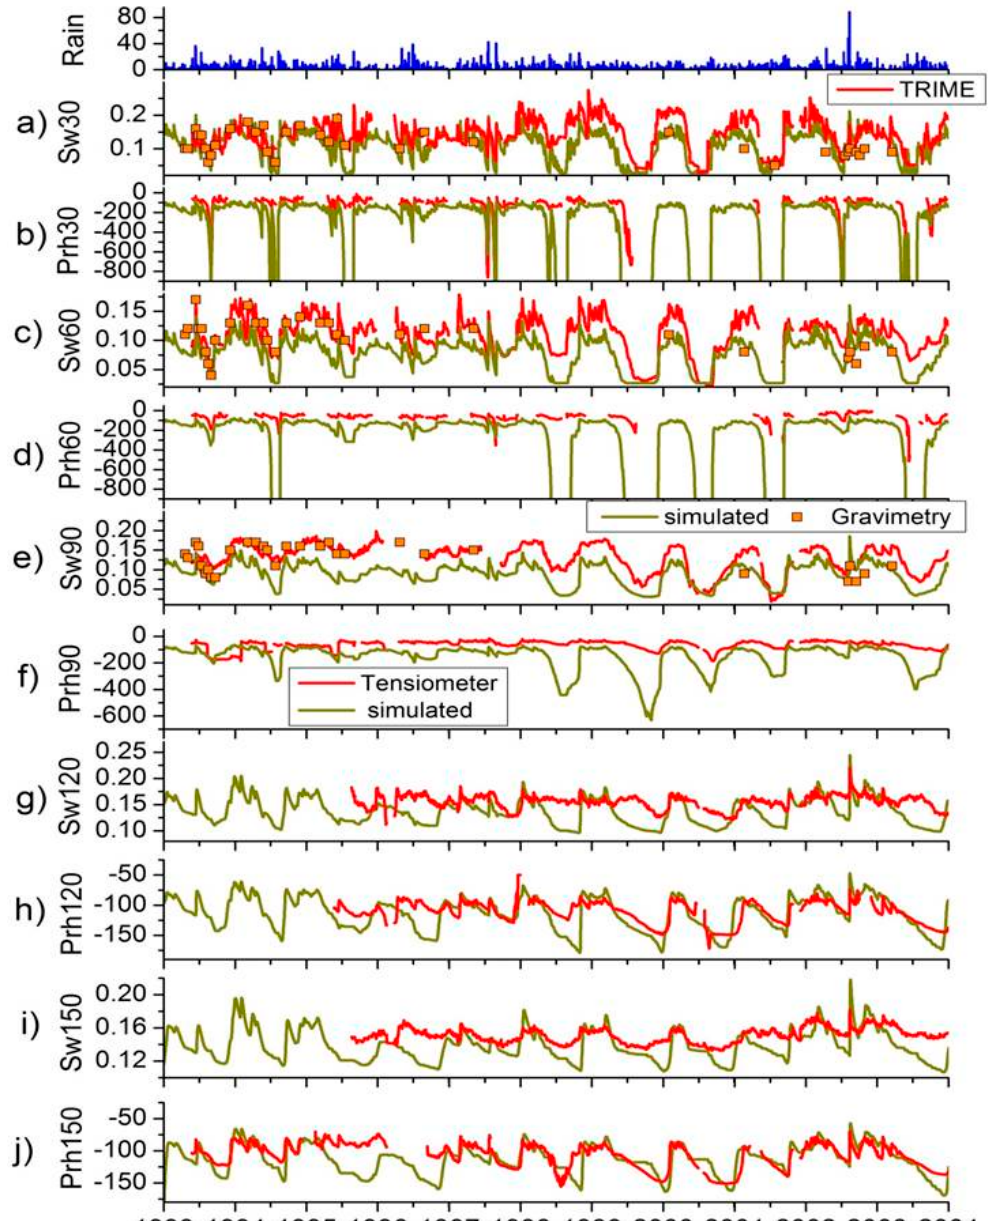
Figure 7. Daily rainfall (Rain) in mm d − 1 , simulated and measured soil water contents (TRIME, Gravimetry) in cm 3 cm − 3 at soil compartments 0–30 cm ( a , Sw30), 30–60 cm ( c , Sw60), 60–90 cm ( e , Sw90), 90–120 cm ( g , Sw120) and 120–150 cm depth ( i , Sw150) and pressure heads in hPa at 30 cm ( b , Prh30), 60 cm ( d , Prh60), 90 cm ( f , Prh90), 120 cm ( h , Prh120) and 150 cm depth ( j ,